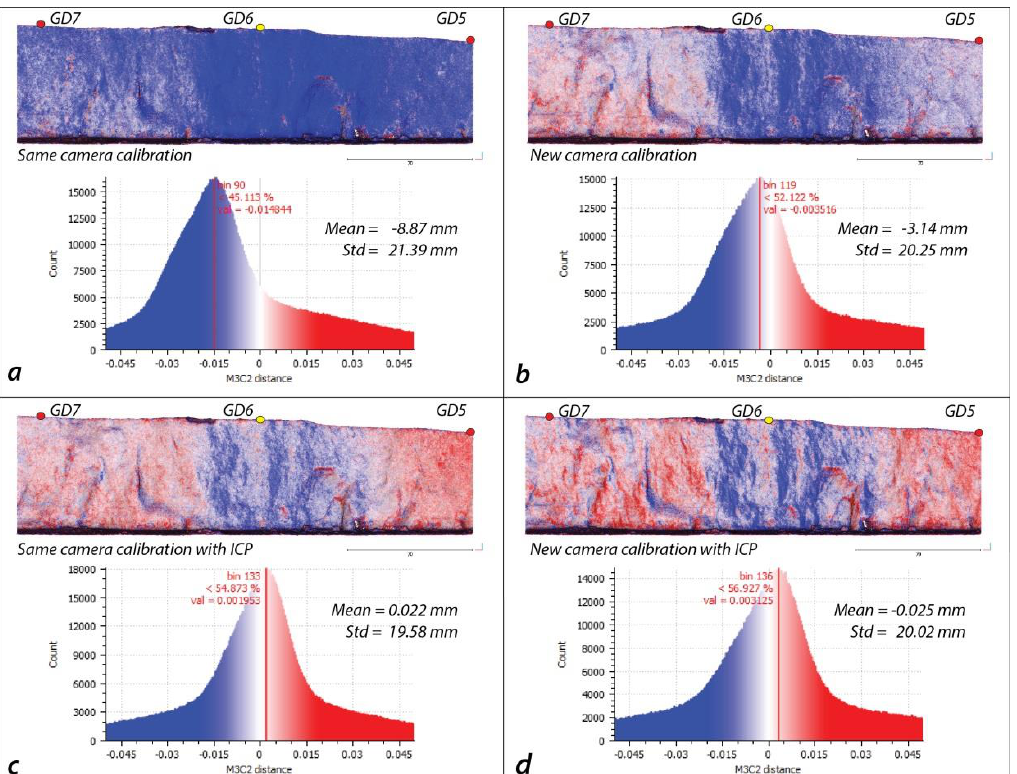
Figure 3 : Comparison between January point cloud (cloud 1) with all the GCP and variation of the same point cloud a. Same Camera calibration and GD6 GCP removed (cloud 2) . b. New Camera calibration and GD6